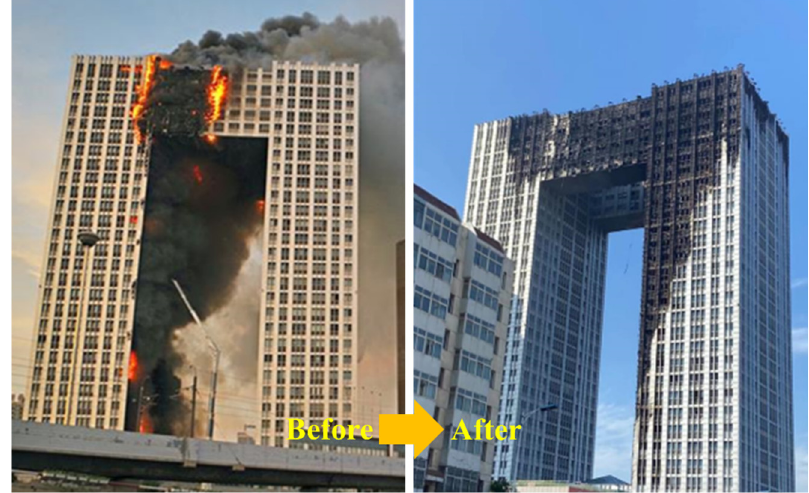
Figure 2. Before and after fire effect in residential building, Liaoning Province, China.